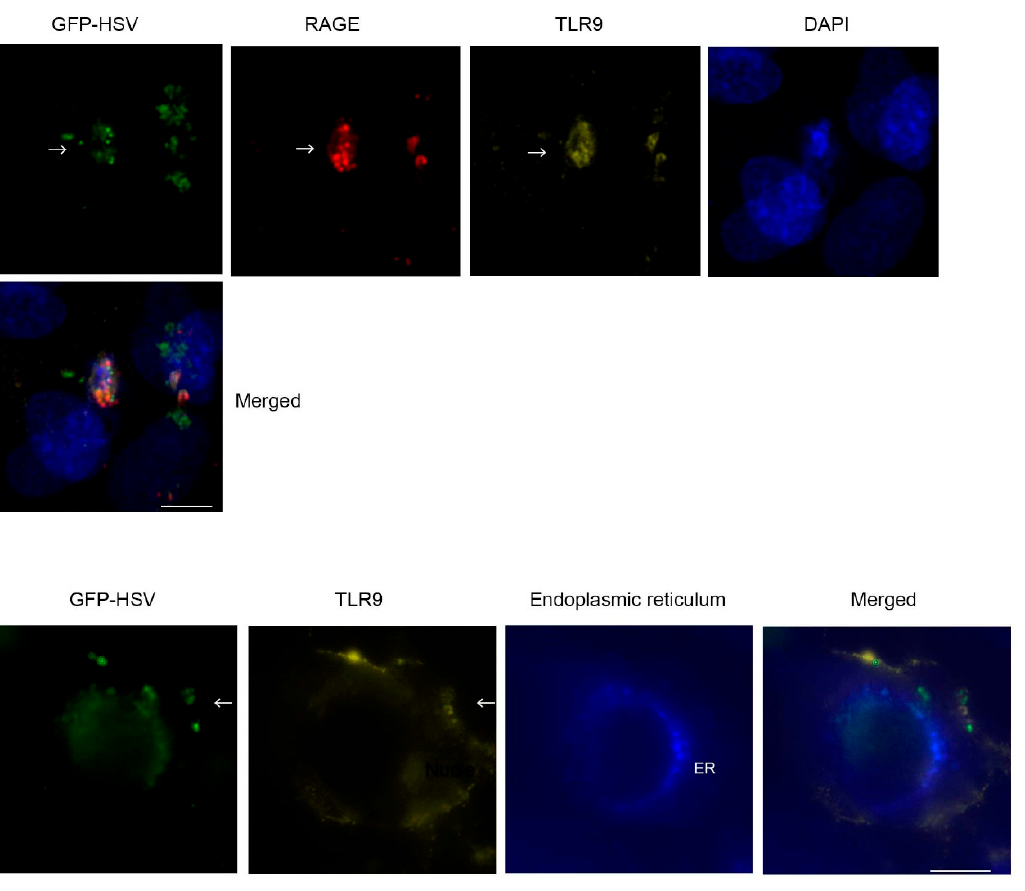
Figure 3. Cellular localization of TLR9, RAGE, and HSV-1. HCEn cells were infected with GFP-HSV (at MOI 50, arrow (green)) and stained for cell surface RAGE (arrow (red): PE-labeled) and TLR9 (Alexa647-labeled, arrow (yellow)) without permeabilization. HSV-1 is colocalized with cell surface RAGE, which partly overlapped with the accumulated TLR9 expression (upper panel). Lower panel: GFP-HSV (arrow (green)) was associated with TLR9 (arrow (yellow)) near cell surface. TLR9 expression was transitioned to endoplasmic reticulum (ER, blue) surrounding nucleus (lower panel). Nuclear transition of GFP-HSV is also observed at 3 h PI. Bar indicates 10 µm.